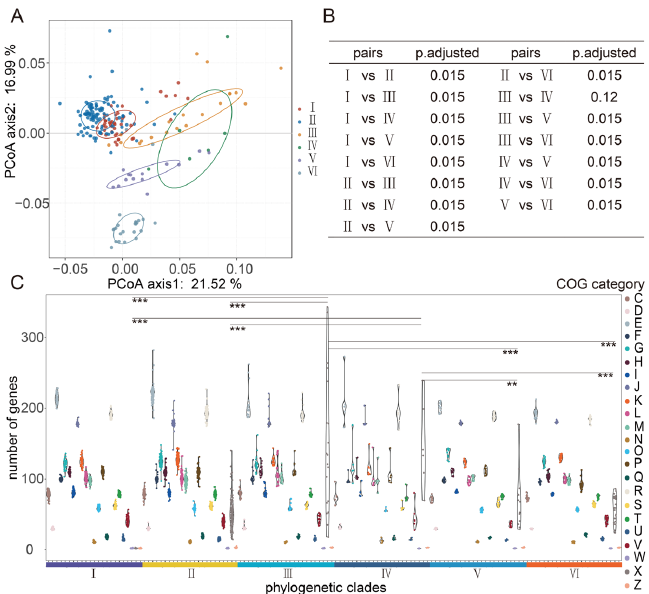
Figure 3. Clusters of orthologous groups (COGs) in the genome L. fermentum strains distributed in phylogenetic clades I, II, III, IV, V, and VI separately. ( A ) Principal coordinates analysis (PCoA) of COGs in the genome of L. fermentum strains in 6 main phylogenetic clades; ( B ) PERMANOVA and pairwise comparison analysis COGs in the genome of L. fermentum strains in 6 phylogenetic clades; ( C ) the violin plots show the number of genes annotated with diverse COG functional categories in L. fermentum in the phylogenetic clades I, II, III, IV, V, and VI and * indicate a significant difference in functional categories X between different group (** p < 0.01, *** p <